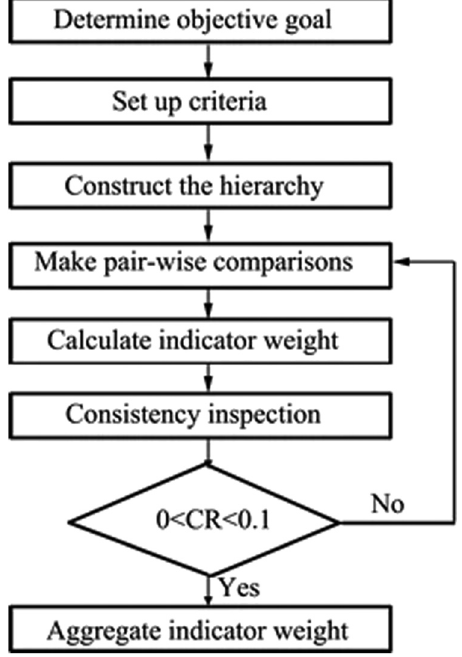
Figure 3: Flowchart for the AHP [ 30 ] .